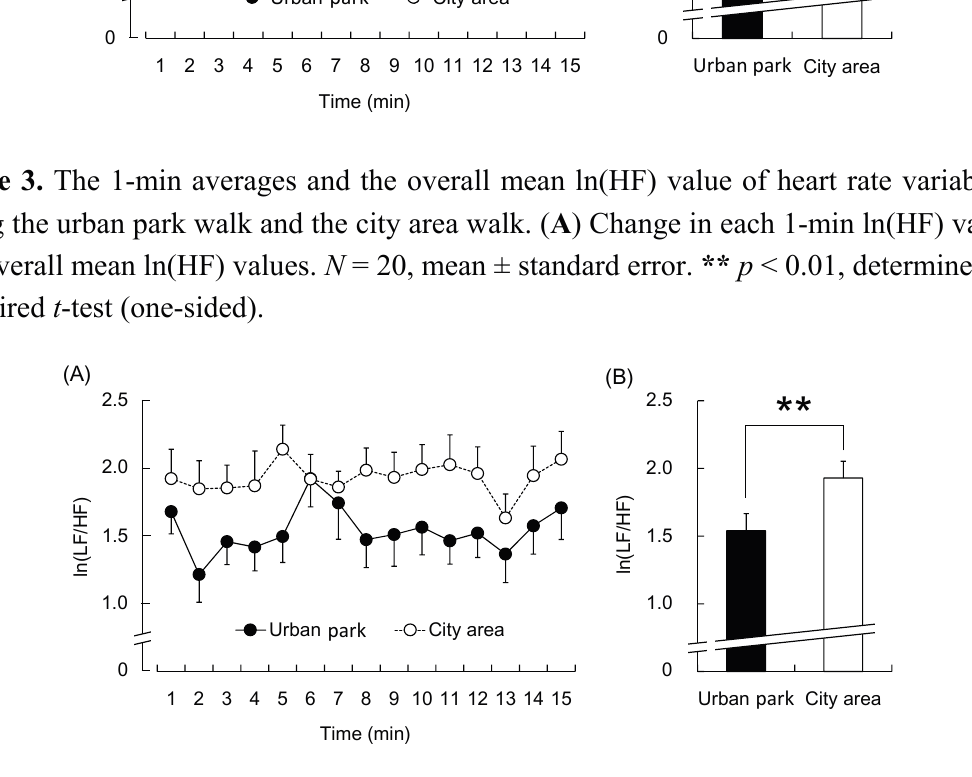
Figure 4. The 1-min averages and the overall mean ln(LF/HF) value of heart rate variability during the urban park walk and the city area walk. ( A ) Change in each 1-min ln(LF/HF) value; ( B ) Overall mean ln(LF/HF) values. N = 20, mean ± standard error. ** p < 0.01, determined by the paired t -test (one